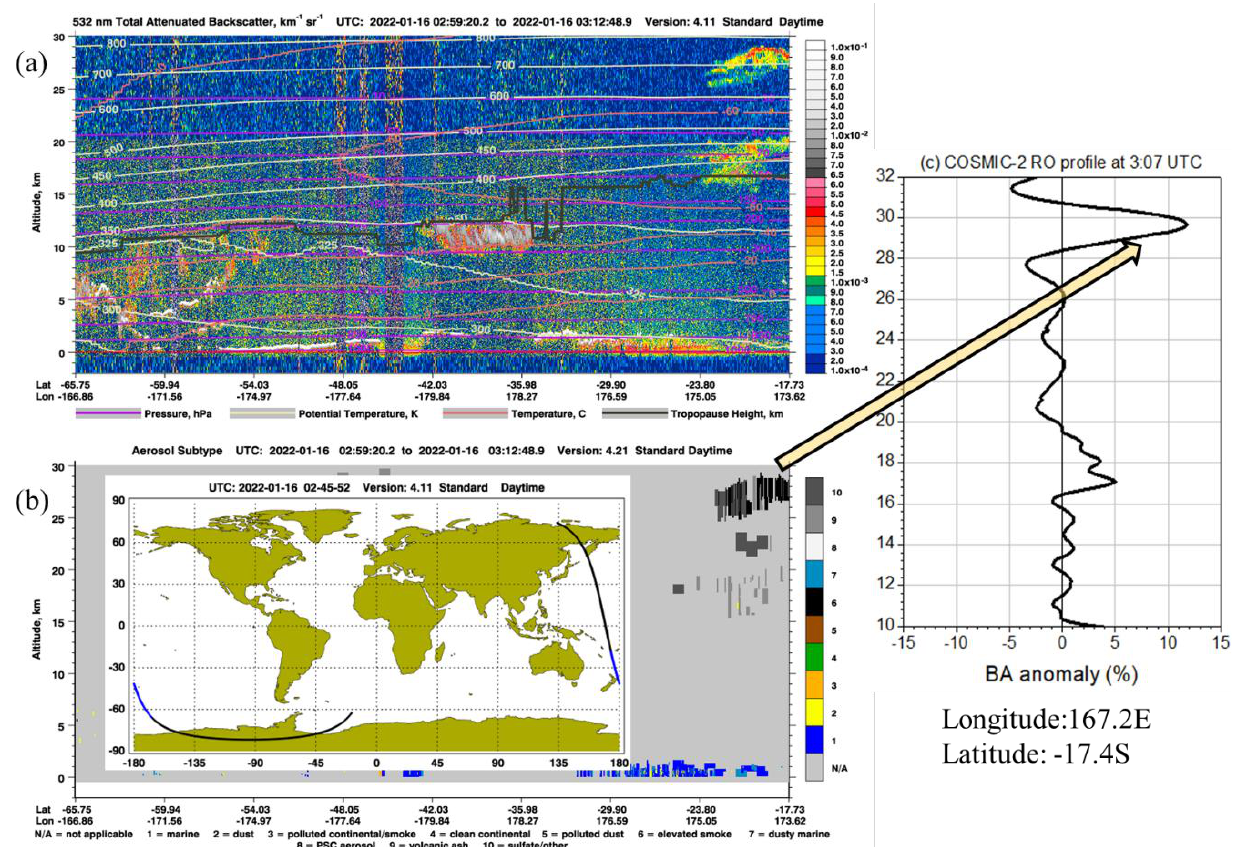
Figure 4. ( a ) CALIPSO 532 nm total attenuated backscatter coefficient; ( b ) the CALIPSO aerosol subtypes at @3 UTC on 16 January 2022; ( c ) the available COSMIC – 2 RO bending angle anomaly at 3:07 UTC on 16 January 2022.